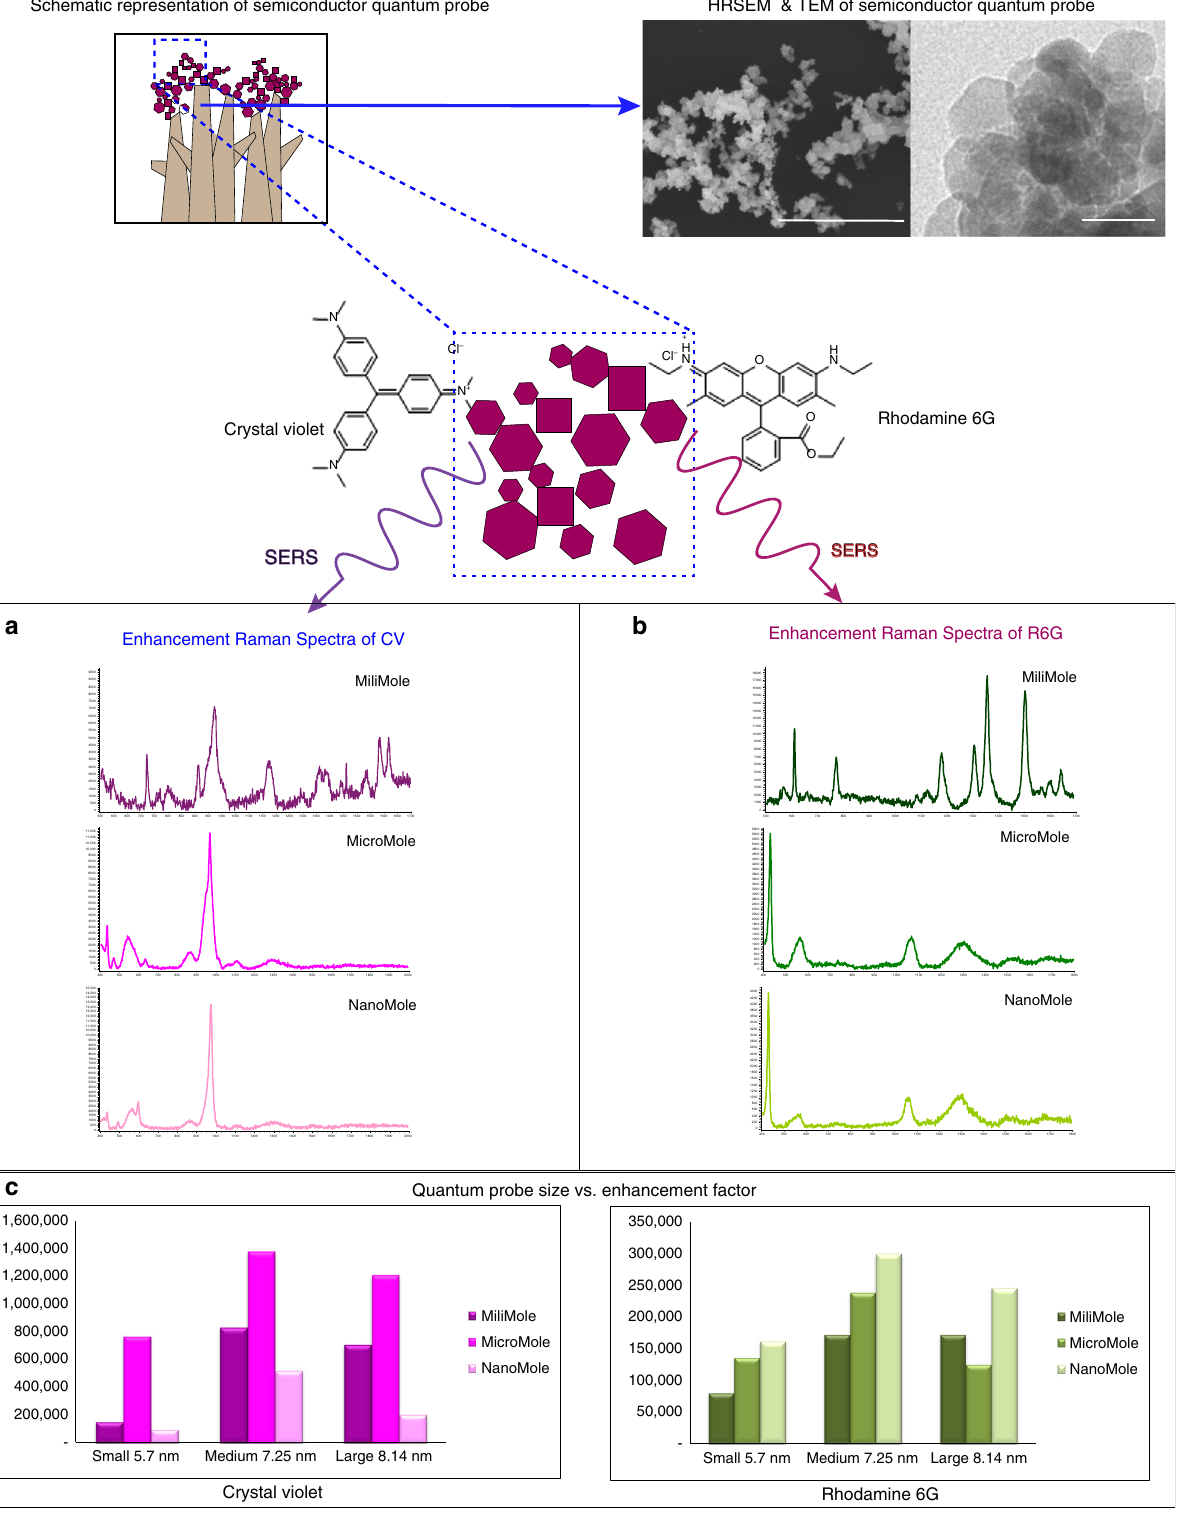
Fig. 4 SERS-based enhancement for Crystal Violet and Rhodamine 6G. Signi fi cant enhancement ~10 6 was achieved with ZnO-based semiconductor quantum probe, which is outstanding for a non-plasmonic material. Concentration-based SERS spectra of Crystal Violet ( a ) and R6G ( b ). The “ x ” axis of the spectra display Raman Shift (cm − 1 ) and “ y ” axis displays arbitrary units. Bar chart represents enhancement factor with reference to the concentration ( c ). Scale bar for SEM 500 nm and for TEM = 20